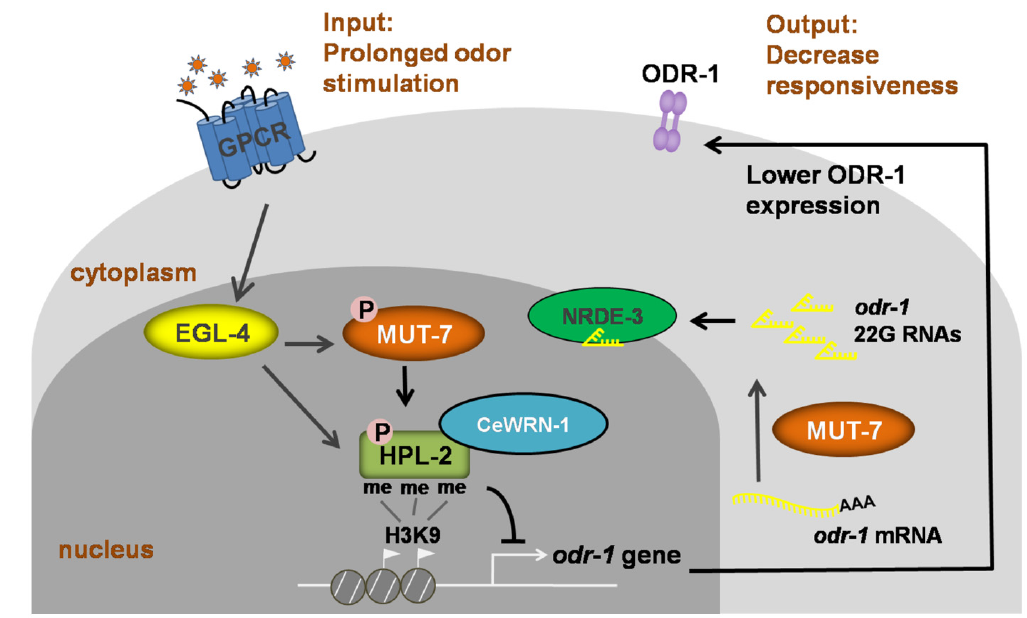
Figure 3. Signaling model of long-term olfactory learning in the AWC neuron of C. elegans . Wild-type AWC neurons enable the worm to detect an attractive odor and move toward it. When the worm is exposed to an odor for a long time, EGL-4 accumulates in the nucleus. Cytoplasmic MUT-7 mediates the synthesis of 22G siRNAs that target odr-1 and the siRNAs are carried by NRDE-3 into the nucleus. Once the siRNA enters the nucleus, EGL-4 phosphorylates nuclear MUT-7, resulting in the association between CeWRN-1 and HPL-2. HPL-2 then binds to methylated histone H3.3, thereby downregulating odr-1 transcription. Lower levels of the ODR-1 protein promote olfactory learning and worms ignore the previously attractive